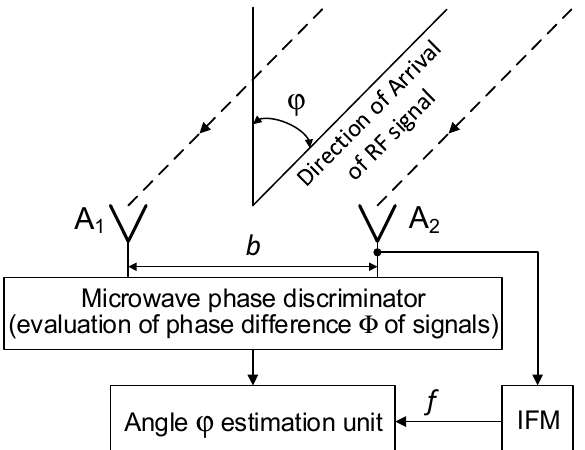
Figure 4. General scheme of the direction finding (DF) device using the monopulse phase method.